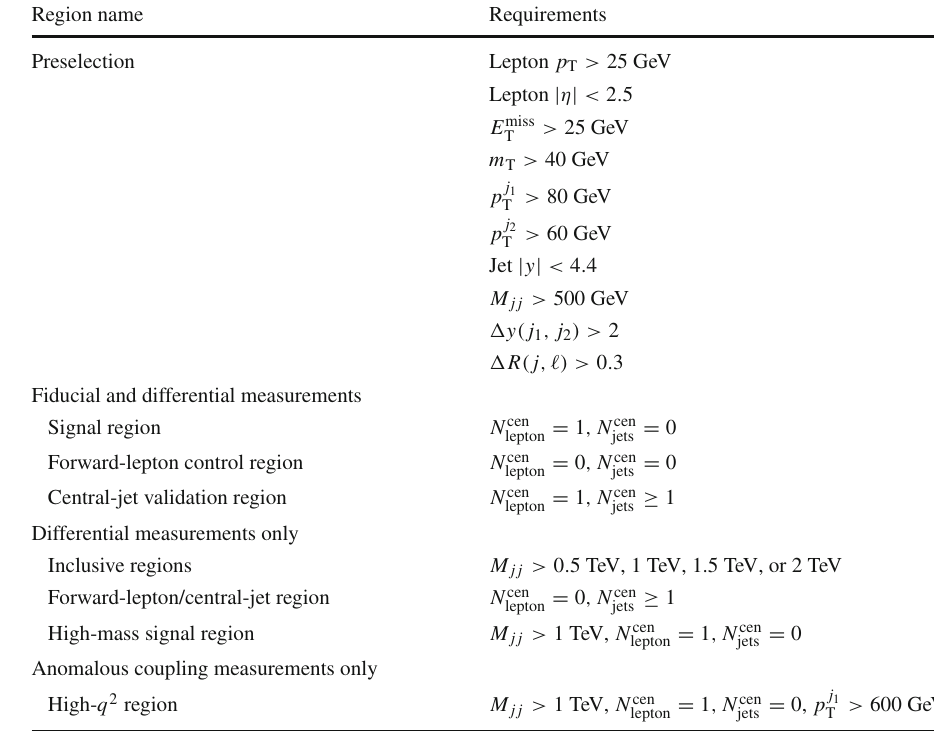
Table 1 Phase-space definitions at the generated particle level. Each phase-space region includes the preselection and the additional requirements listed for that region. The variables are defined in Sects. 3.1 and